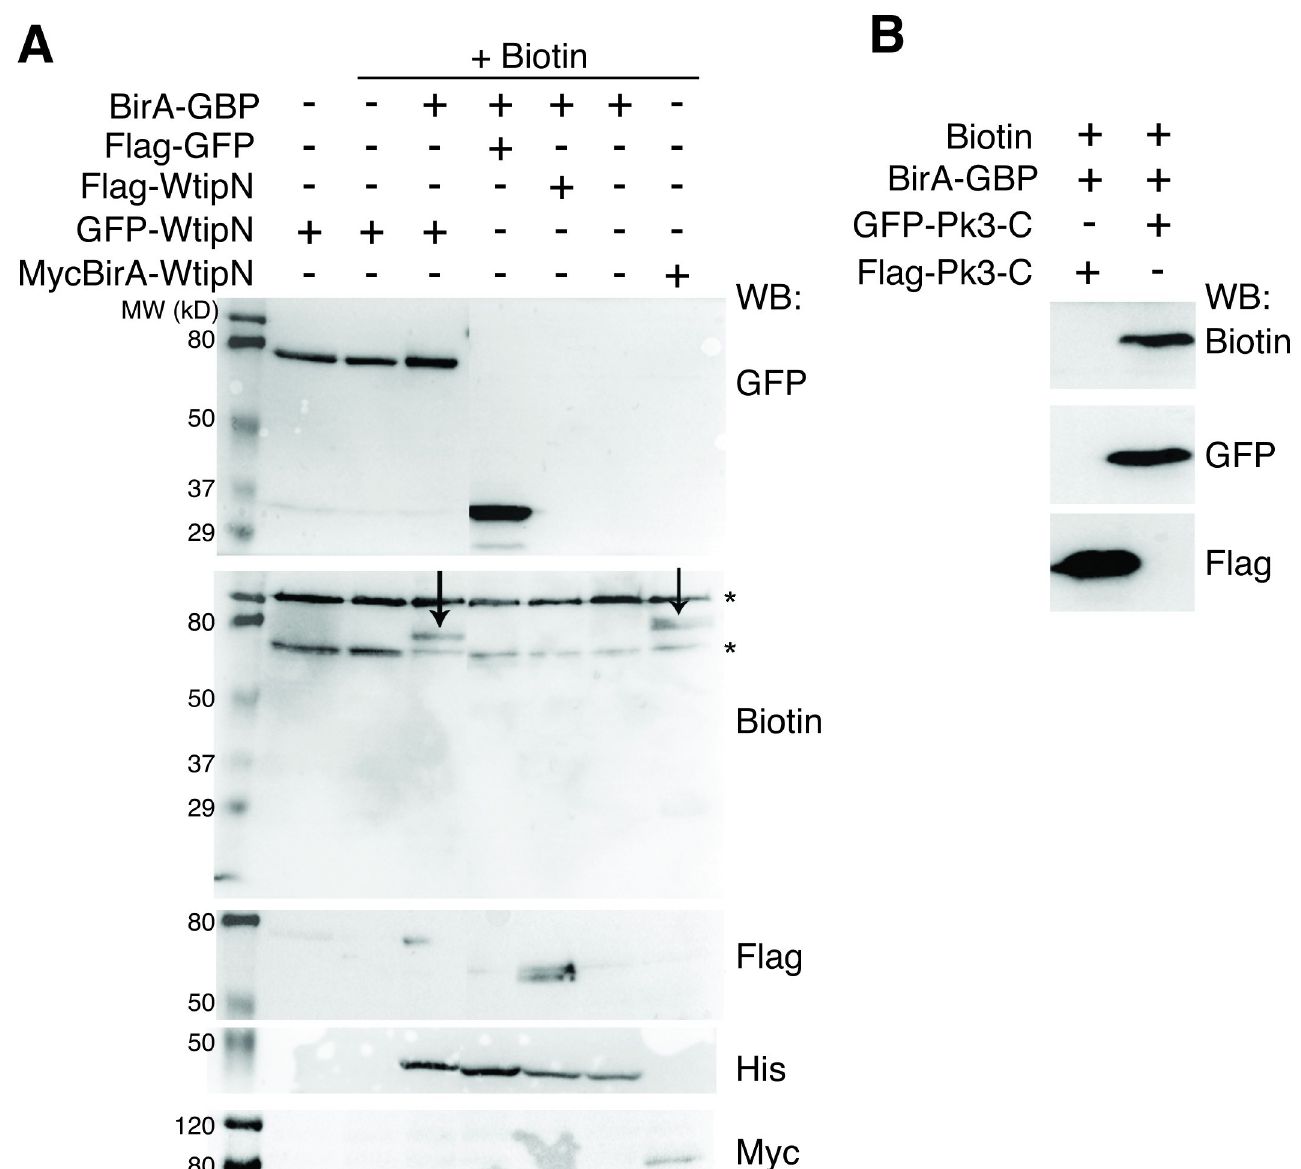
Fig 2. Specificity of BirA-GBP-mediated biotinylation. A, GFP-WtipN but not Flag-WtipN is biotinylated (left arrow) by BirA-GBP in the presence of biotin. MycBirA-WtipN is a positive control for biotinylation (right arrow). B, GFP-Prickle3C protein, but not Flag-Prickle3C, was biotinylated by BirA-GBP. Protein expression levels are assessed with tag-specific antibodies as indicated (A, B). https://doi.org/10.1371/journal.pone.0259068.g002 biotinylates GFP-Prickle3C but not Flag-Prickle3C [12] (Fig 2B) . These results suggest that TPB may be useful for protein network analysis for GFP-tagged proteins in general.